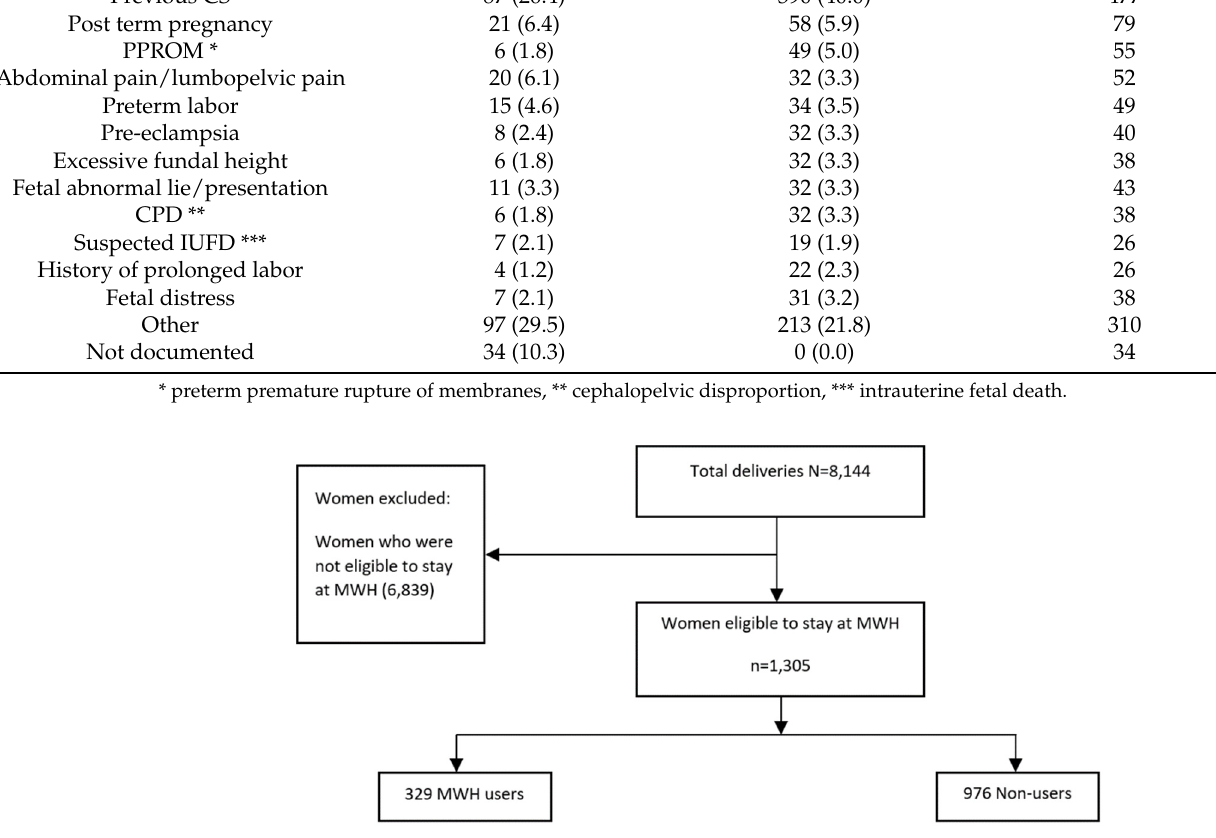
Figure 1. Inclusion and exclusion of users and non-users. Table 1. Indications for admission to the MWH.